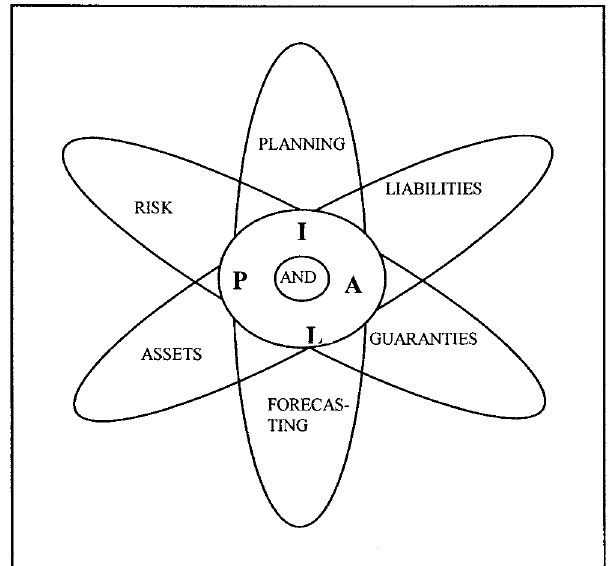
Fig 2. Mechanic IALP and FFS, IRM and IALMS operation model, where IALP works as a bearing, which puts together forecasting and planning, risk and uncertainty, assets